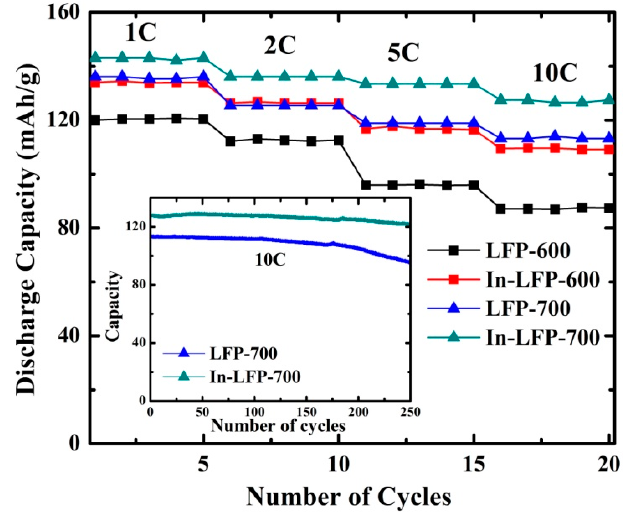
Figure 6. Rate capability curves of LFP-600, In-LFP-600, LFP-700, and In-LFP-700 samples during continuous cycling at different charging rates. The inset shows the capacity retention for LFP-700 and In-LFP-700 sample at 10 C rate.